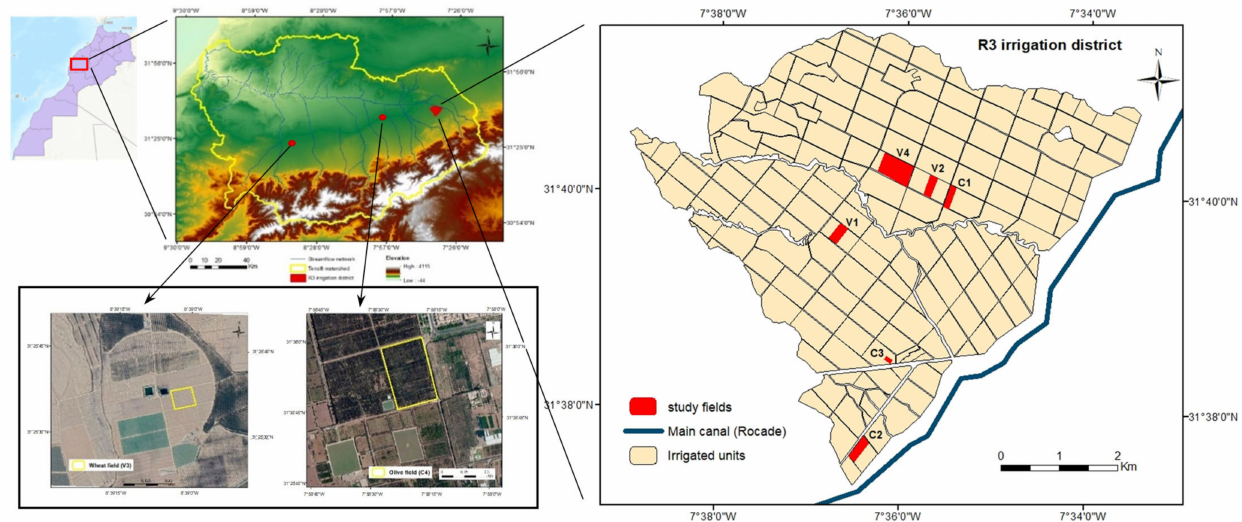
Figure 1. Map of the study area. Upper left panel: Location of the study area in the Tensift watershed (Morocco); Right panel: R3 irrigation district and location of six experimental fields (C1, C2, C3, V1, V2, V4); Lower left panel: Location of two other experimental fields (V3,